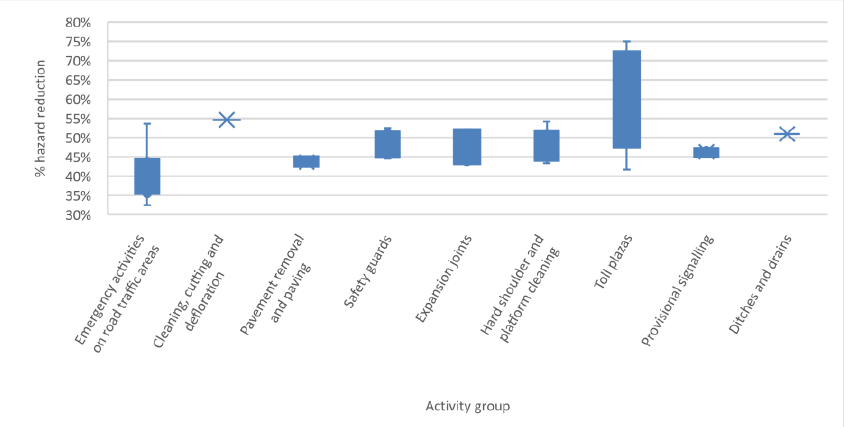
Figure. 8. Reduction of the activities risk level after the adoption of proposed safety measures